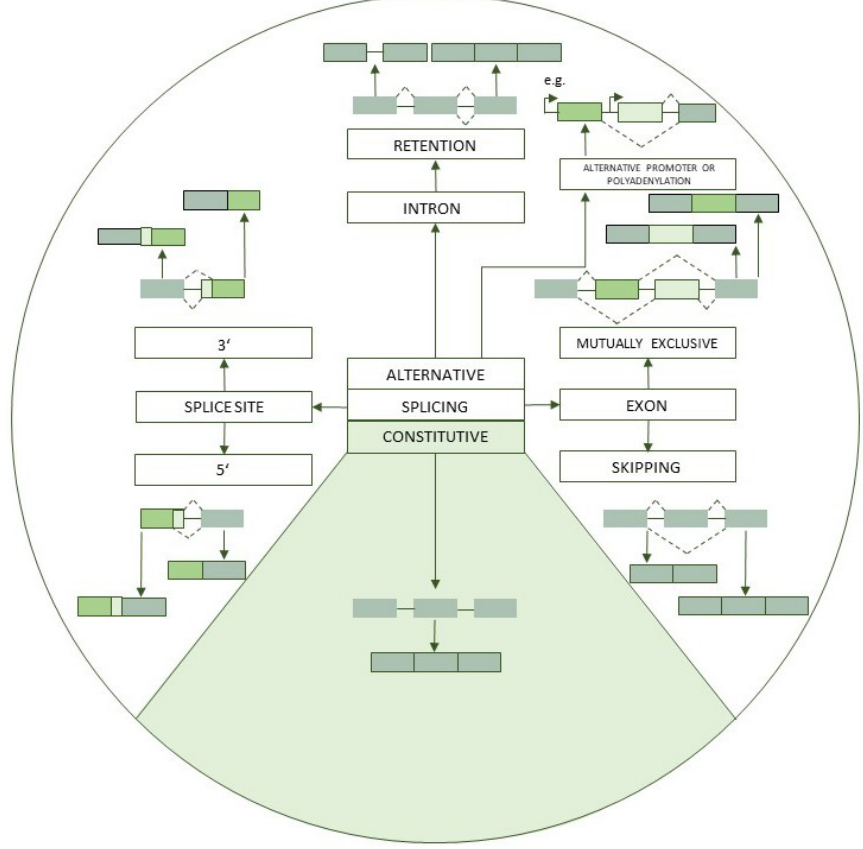
Figure 1. Alternative splicing mechanisms. The green rectangles represent the exons, the horizontal lines connecting the rectangles represent the introns. Arrows point to the products of the respective splicing event. The constitutive splicing mechanism is represented in the light green section of the diagram. The different shades of green in the rectangles are used to accentuate the segment affected by a certain alternative splicing mechanism.